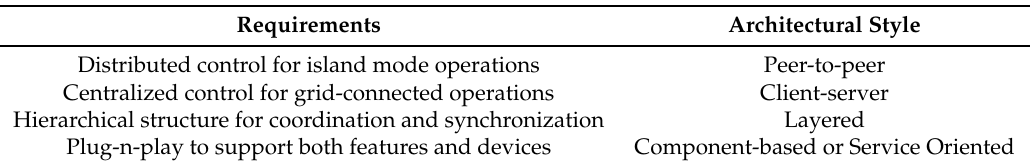
Table 2. Compatibility of functional requirement with the architecture